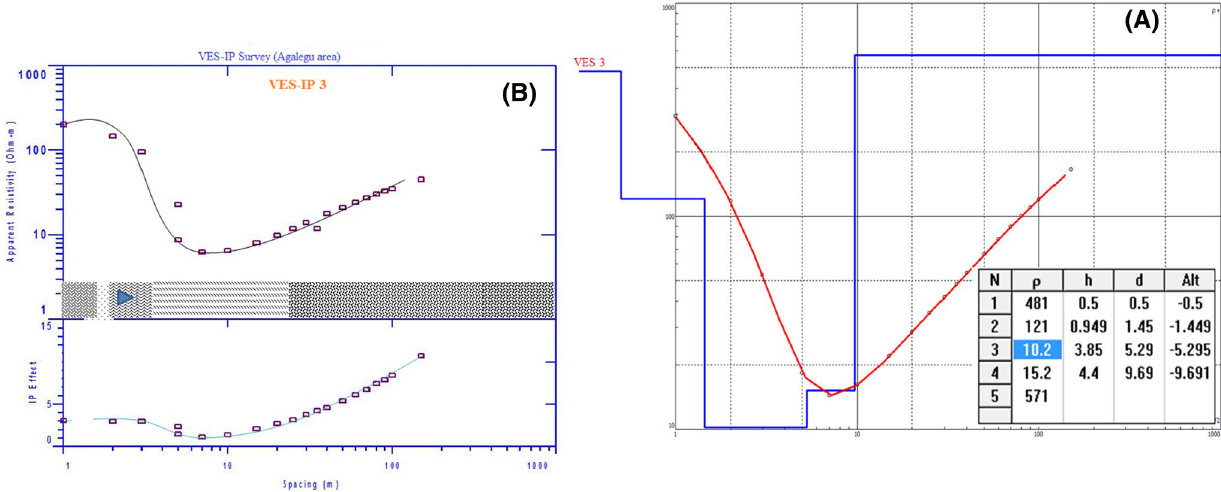
Fig. 5 a Geoelectric units for VES 3 (Agalegu area) with apparent resistivity curve for depth to the water table, b VES-IP curves jux- taposed with adjacent BH 6 data from the Agalegu area. Note : Slight